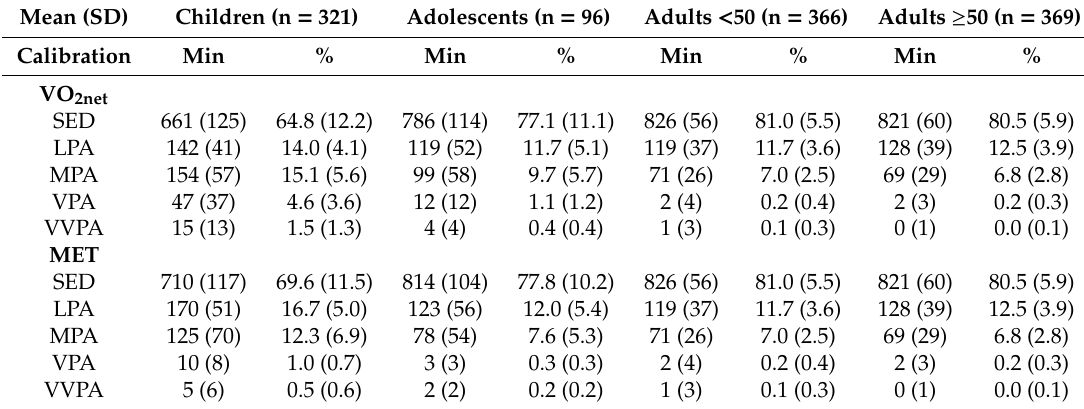
Table 2. Time spent daily (min and % of wear time) in di ff erent intensity levels by age-group and calibration method for the hip